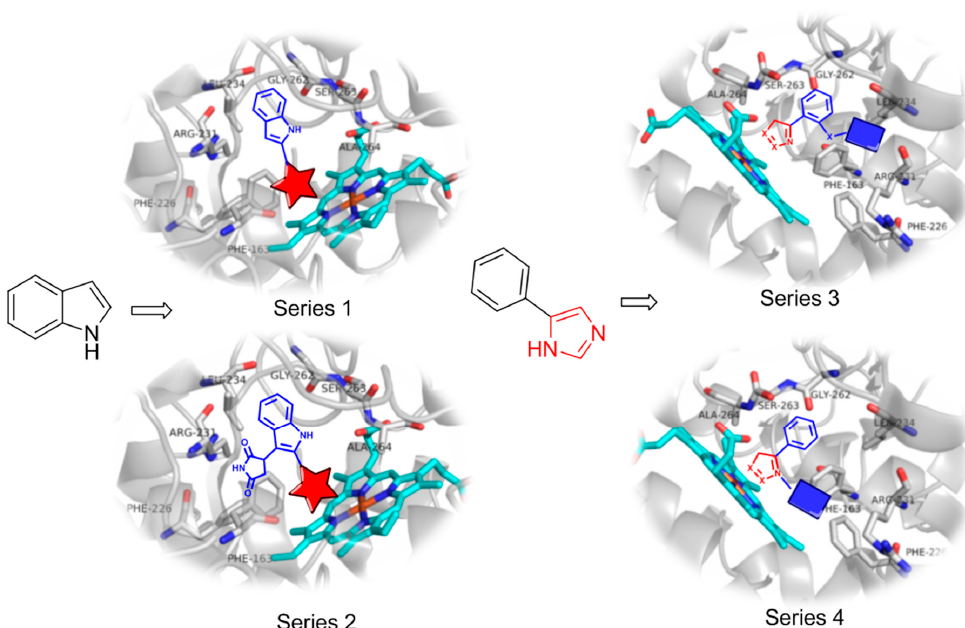
Figure 2. Design strategies of the four series of inhibitors. Because the parent compounds of series 1 and 2, indole and PF-0684003, respectively, do not interact with the heme iron, various heme binding ligands were attached to the indole scaffold. The imidazole ring interacts with the heme iron, and thus various fragments were attached to the phenyl ring in series 3 and the imidazole ring in series 4 to strengthen the binding to the active site of IDO1.